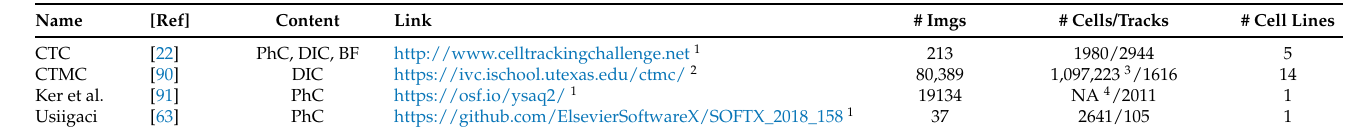
Table 4. Details of available annotated data for cell tracking in traditional label-free sequences: dataset name (Name); reference ([Ref]); type of microscopy data (Content); url (Link); number of annotated images (# imgs), annotated cells/tracks (# cells/tracks), and cell lines (#cell lines). All links were accessed on 28 August